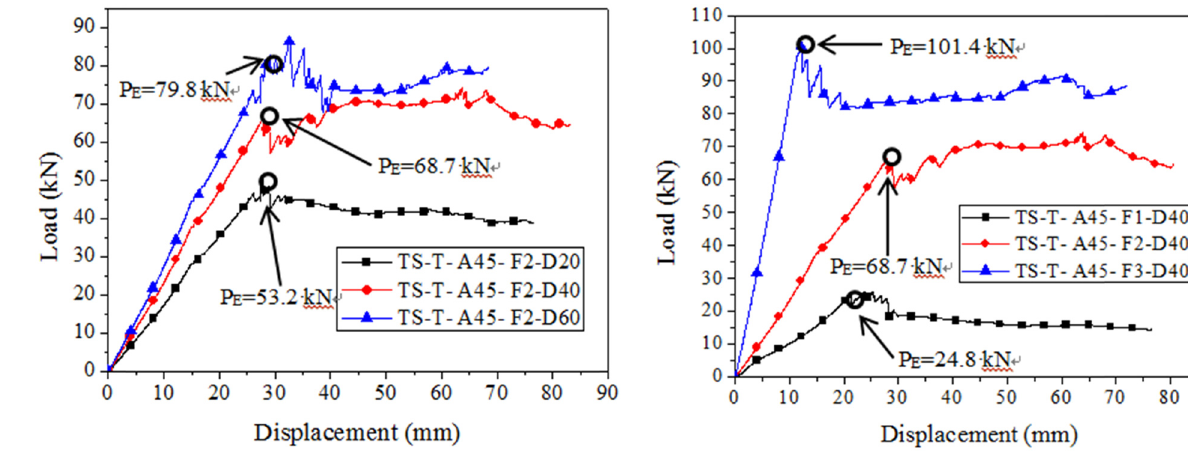
Figure 18: Displacement – load curve of